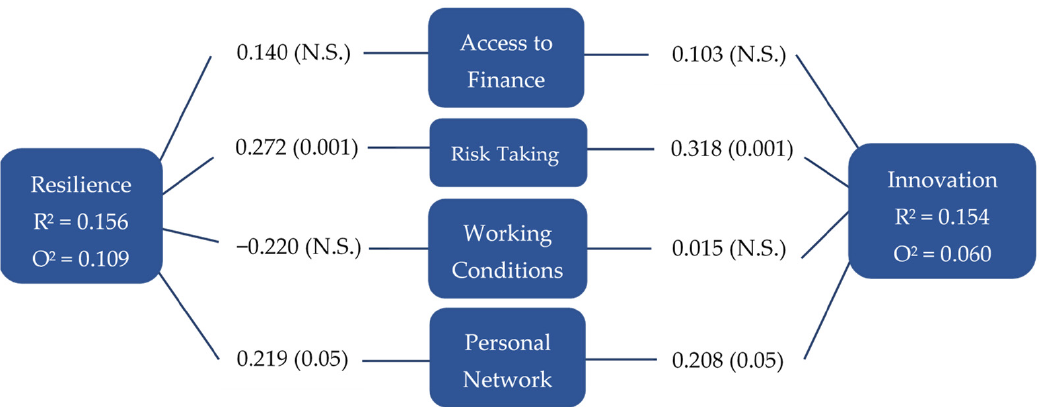
Figure 2. Research Model with PLS-algorithm and bootstrapping results.